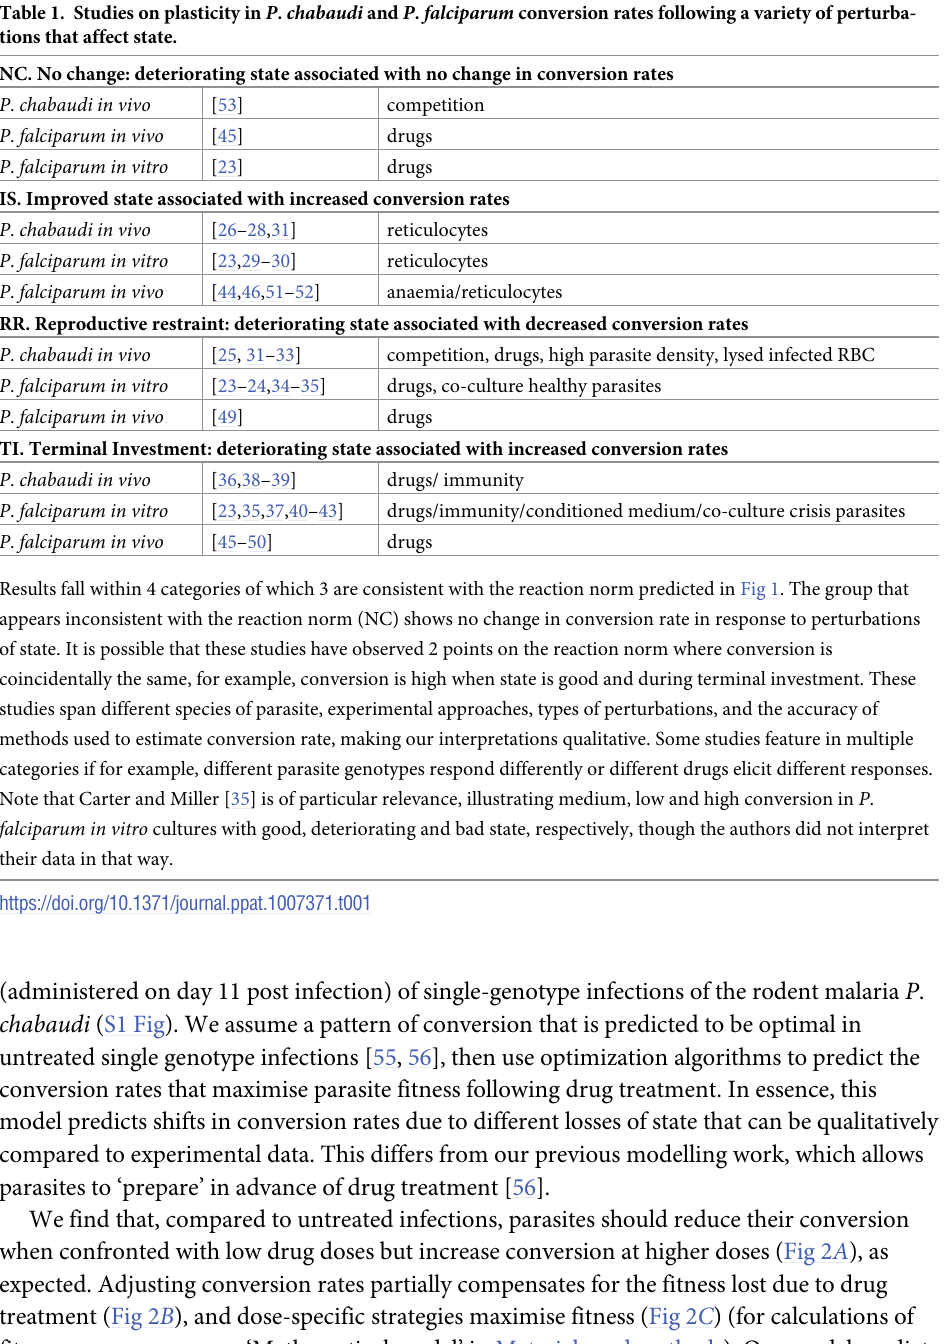
Table 1. Studies on plasticity in P . chabaudi and P . falciparum conversion rates following a variety of perturba- tions that affect state. NC. No change: deteriorating state associated with no change in conversion rates